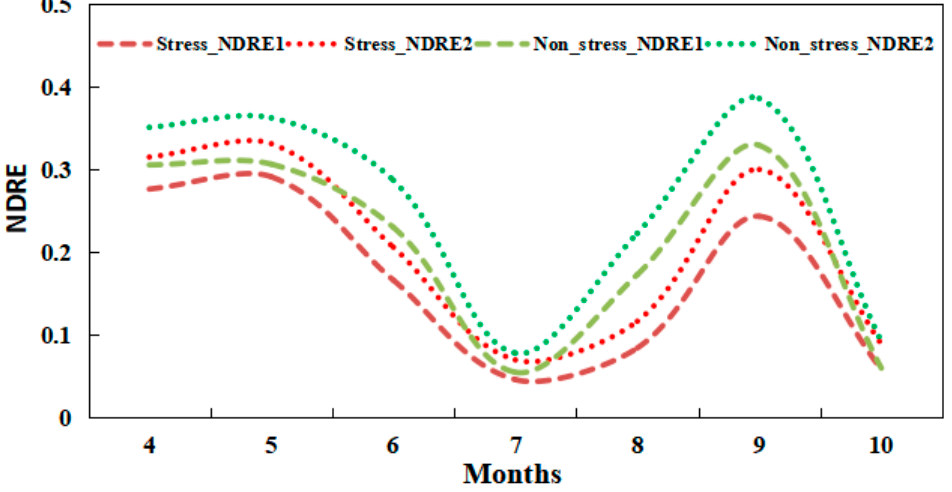
Figure 3. Temporal characteristics of stress signal from a single rice pixel under different stress